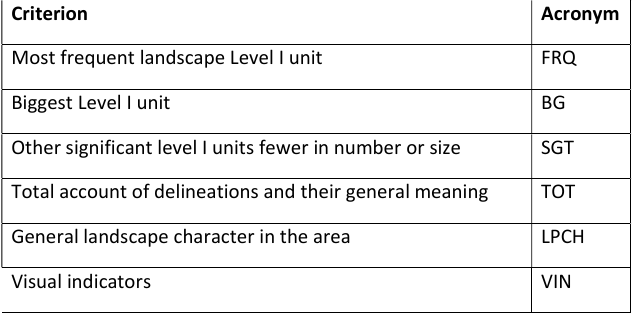
Table 1: Criteria used to generalize Level I landscape units (1:10,000) to Level II landscape units